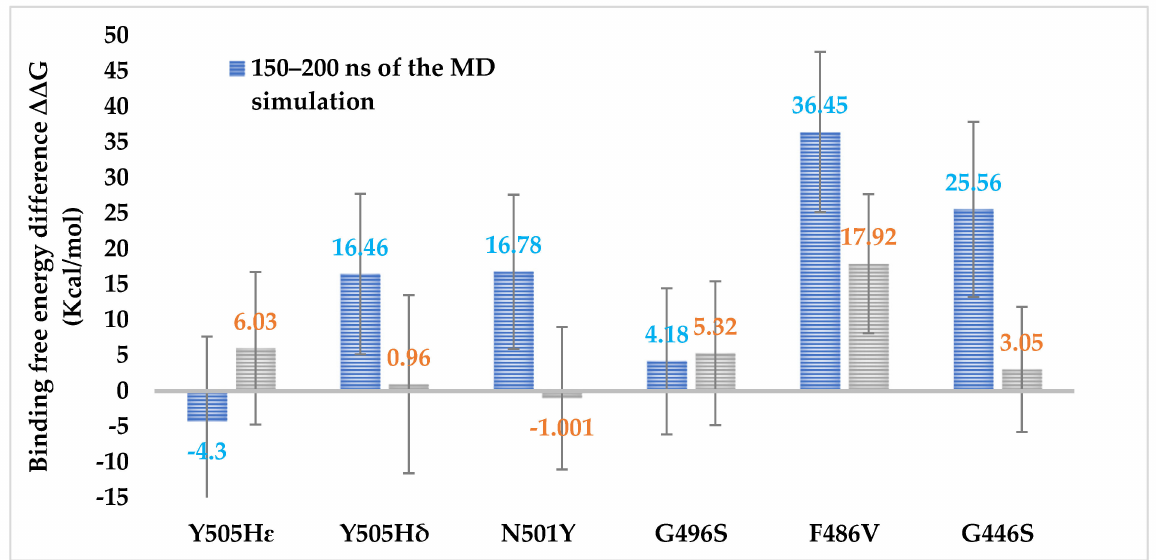
Figure 6. The average change in binding free energy ( ∆∆ G) between the SARS-CoV-2 WT spike RBD and its mutants in unbound and bound conformation, with hACE2 calculated by the Prime/MM- GBSA method. The calculations were performed using both the first 1–25 ns and last 50 ns of the 200-ns (300 ns for the Y505HIE mutant) MD simulations in three